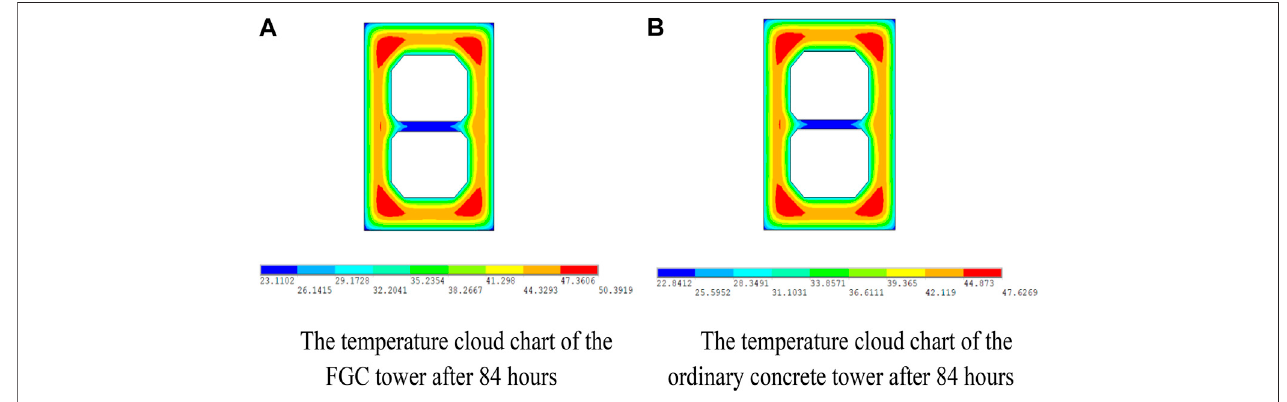
FIGURE10 | The temperature cloud chart under the hydration heat. (A) The temperature cloud chart ofthe FGC towerafter 84 h. (B) The temperaturecloud chart of the ordinary concrete tower after 84 h.